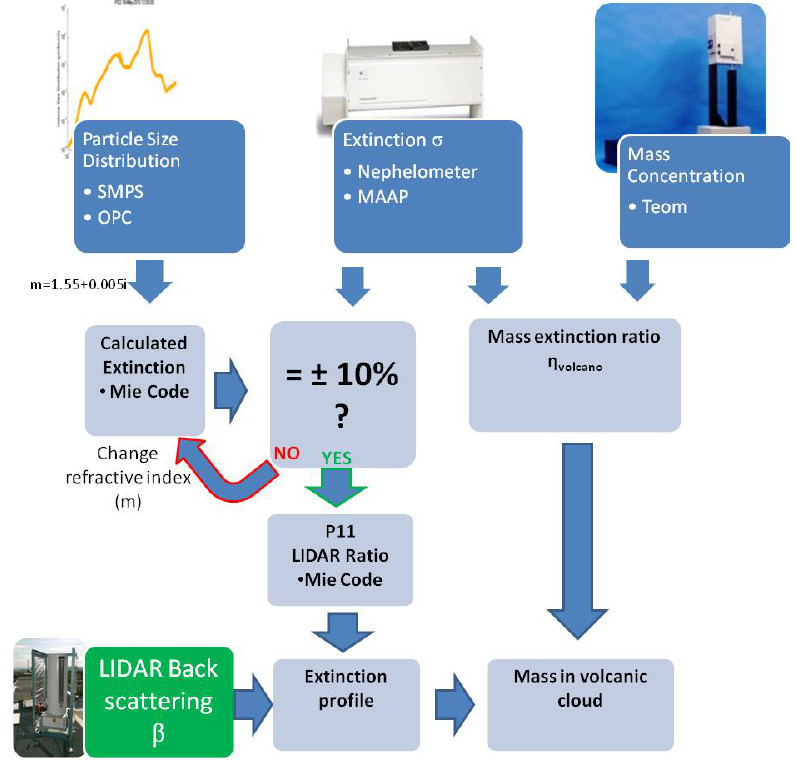
Fig. 6. Diagram of the volcanic mass retrieval. Dark-blue squares correspond to Puy de Dˆome in situ measurements during the volcanic event, green to ground-based measurements, and light blue to calculated